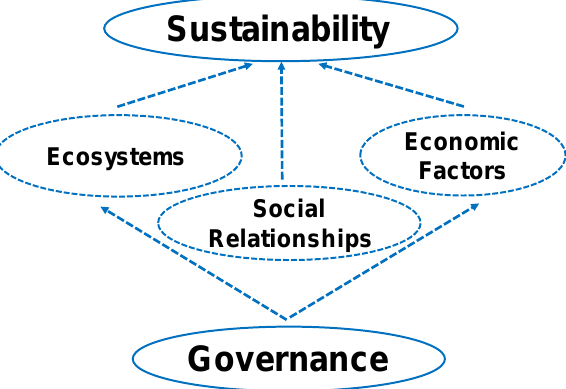
Figure 1. Dimensions of sustainability and community resilience.